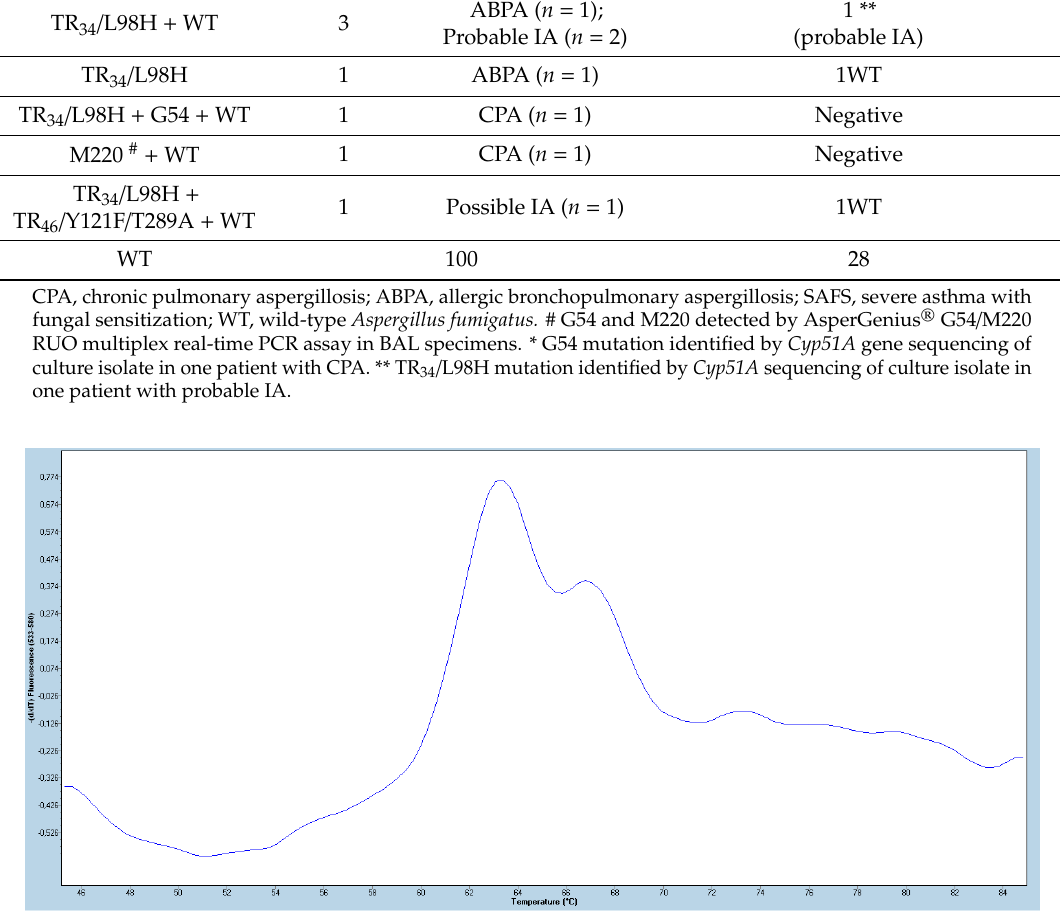
Figure 1. Melting curve analysis showing double peak due to mixed presence of wild-type and G54 mutant.